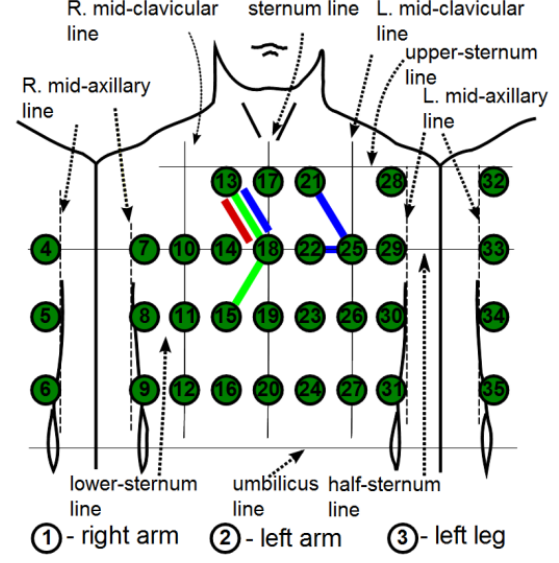
Figure 8. Schematic locations of the best DLs that correctly identify all RCs in 12 out of 15 measurements (blue), DLs with the relative error of 2.5% in RCs identification in 14 measurements (green), and DLs with the relative error of 5% in RCs identification in all 15 measurements